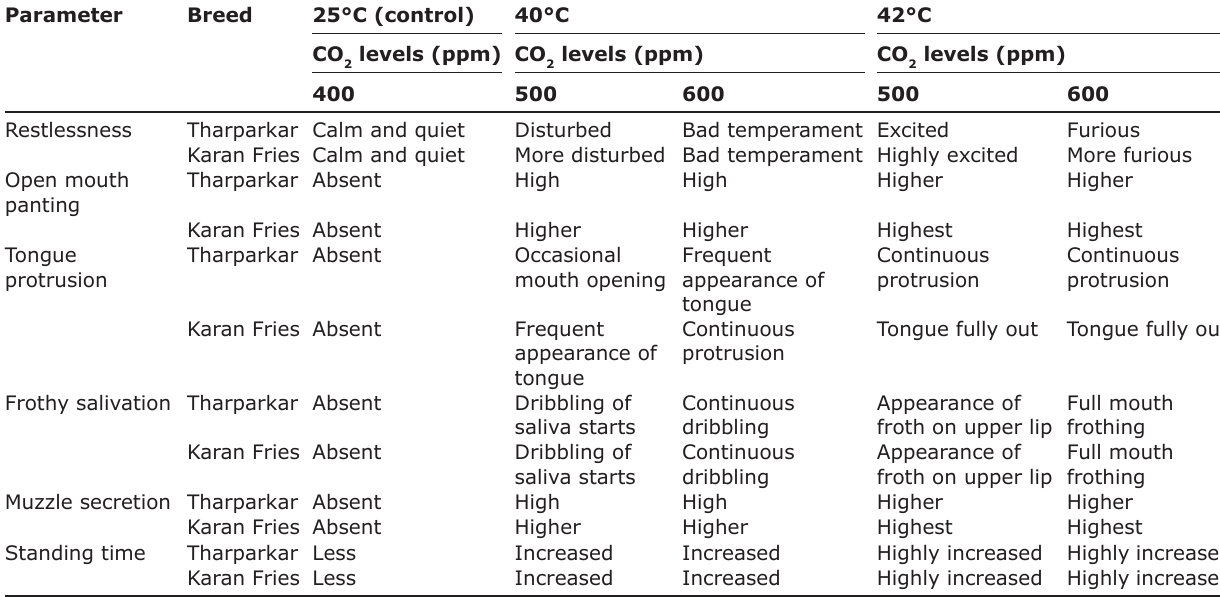
Table-4: Effect of elevated temperature and CO